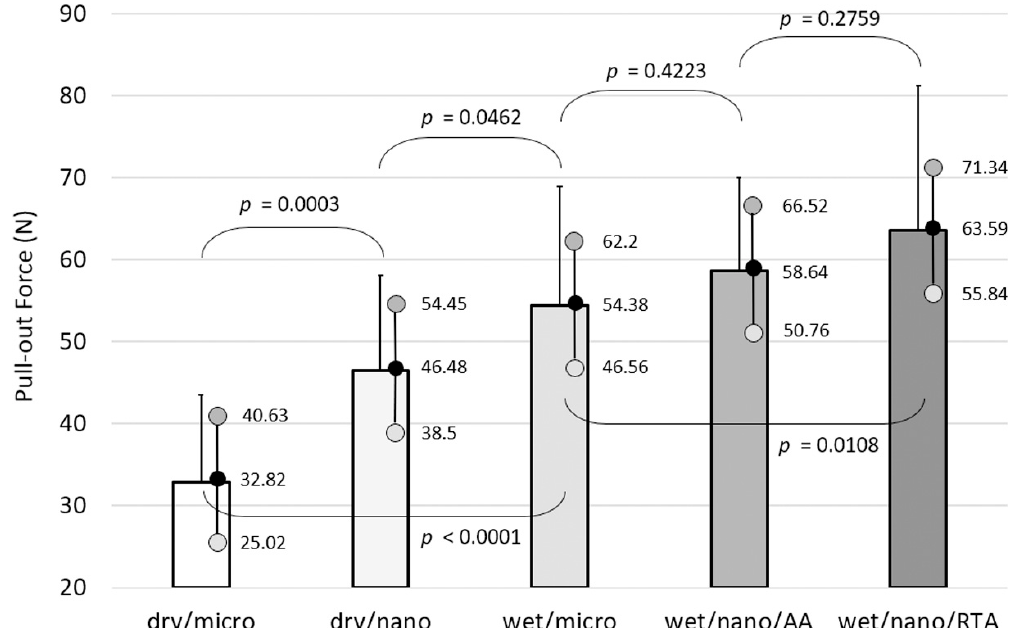
Figure 3. Association between pull-out force and treatment type (implant type), adjusted by gender, strain, side, and implant position. Bars represent adjusted mean values with standard deviations. Black dot = adjusted mean with real value; dark grey w/black outline dot = upper 95% confidence interval limit with real value; light grey w/black outline dot = lower 95% confidence interval limit with real value. p values are provided; p ≤ 0.05 is considered significant.